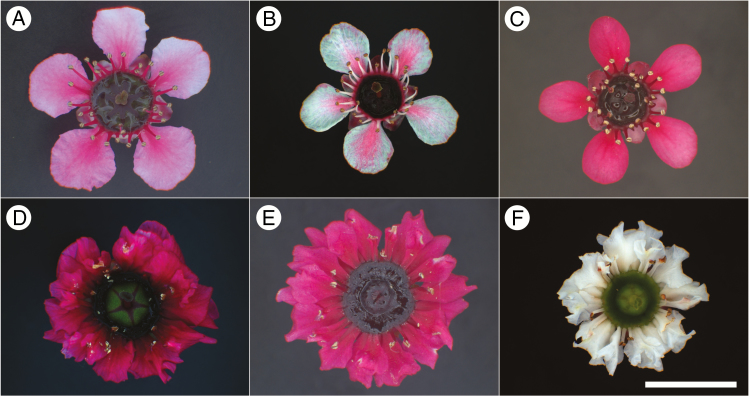
Morphology of Stage 3 open flowers of the six mānuka (Leptospermum scoparium) genotypes used in this study. (A) ‘Martinii’ (MI); (B) ‘Nanum Tui’ (NT); (C) ‘Red Ensign’ (RE); (D) ‘Red Damask’ (RD); (E) ‘Wiri Kerry’ (WK); (F) ‘Snow Flurry’ (SF). Scale bar = 10 mm.